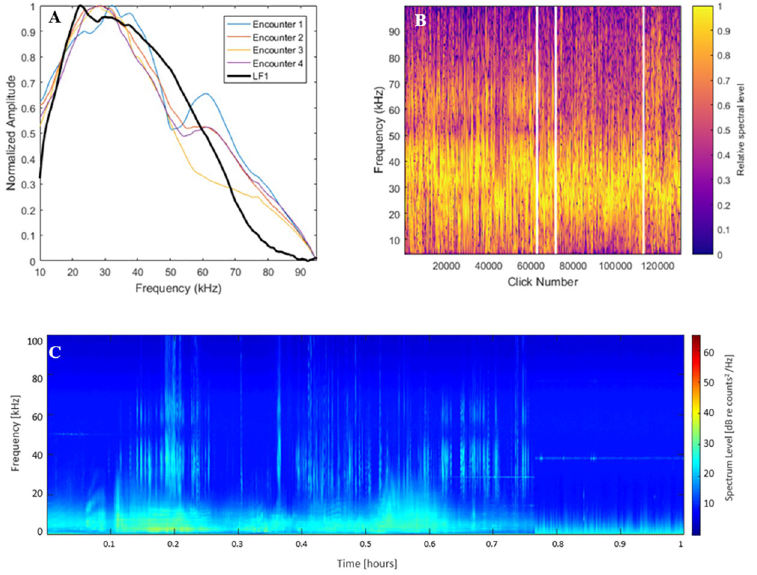
Fig 3. Towed-array S . bredanensis encounters. Figure depicting (a) mean spectra, (b) concatenated click spectra, and (c) an example long-term spectral average of a towed-array acoustic encounter of verified rough-toothed dolphins. Panel (a) includes the mean type spectra of the LF1 click type for comparison. Delineations in panel (b) (white lines) separate clicks coming from encounters 1–4. Panel c shows a long-term spectral average of raw data from an example encounter coming from the towed array